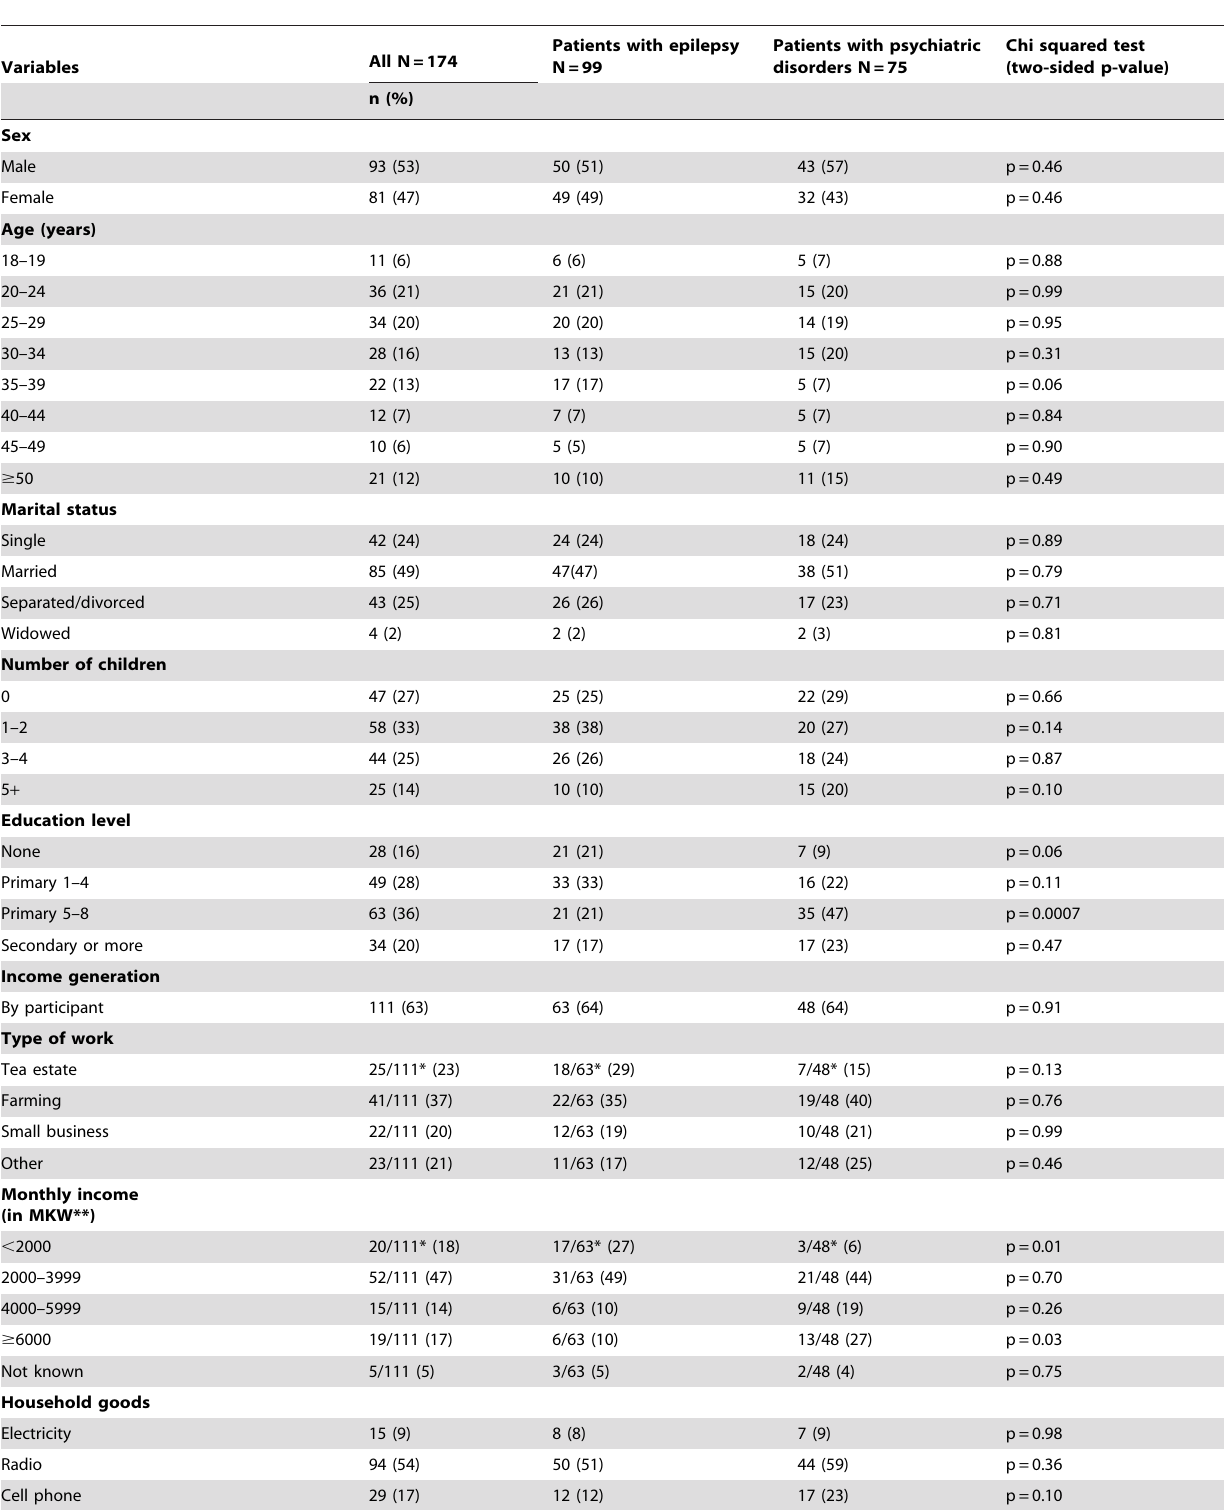
Table 1. Socio-demographic variables of patients with epilepsy and psychiatric disorders.